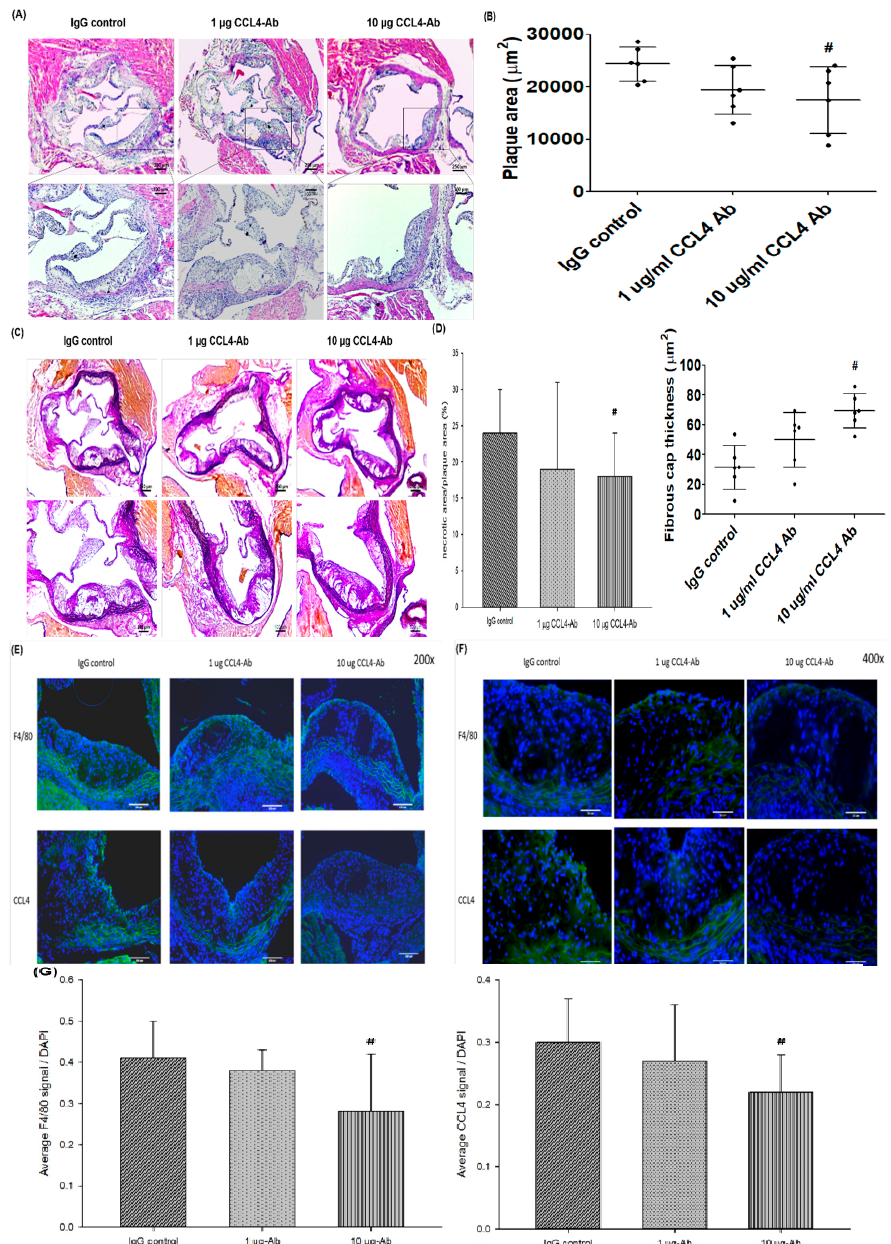
Figure 3. CCL4 antibody treatment reduced the atherosclerotic necrotic area and attenuated macrophage infiltration and CCL4 expressions in plaques. H&E staining of the aorta ( A ; upper: scale bars = 40 µ m; lower: scale bars = 100 µ m). Quantification of the plaque area ( µ m 2 ) ( B , n = 6 in each group). Elastica van Gieson staining of the aorta ( C ; upper: scale bars = 250 µ m; lower: scale bars = 100 µ m). Upper: 40 × magnification; lower: 100 × magnification. Quantification of the necrotic area / plaque area (%) and fibrous cap thickness ( µ m) ( D , n = 6 in each group). The CCL4 inhibition groups showed reduced numbers of macrophages and CCL4 expression in plaques ( E , 200 × magnification, scale bars = 100 µ m; F , 400 × magnification, scale bars = 50 µ m). Quantification of the average F4 / 80 signal / DAPI and CCL4 signal / DAPI ( G , n = 6 in each group). # p < 0.05 compared with the IgG 2A isotype control